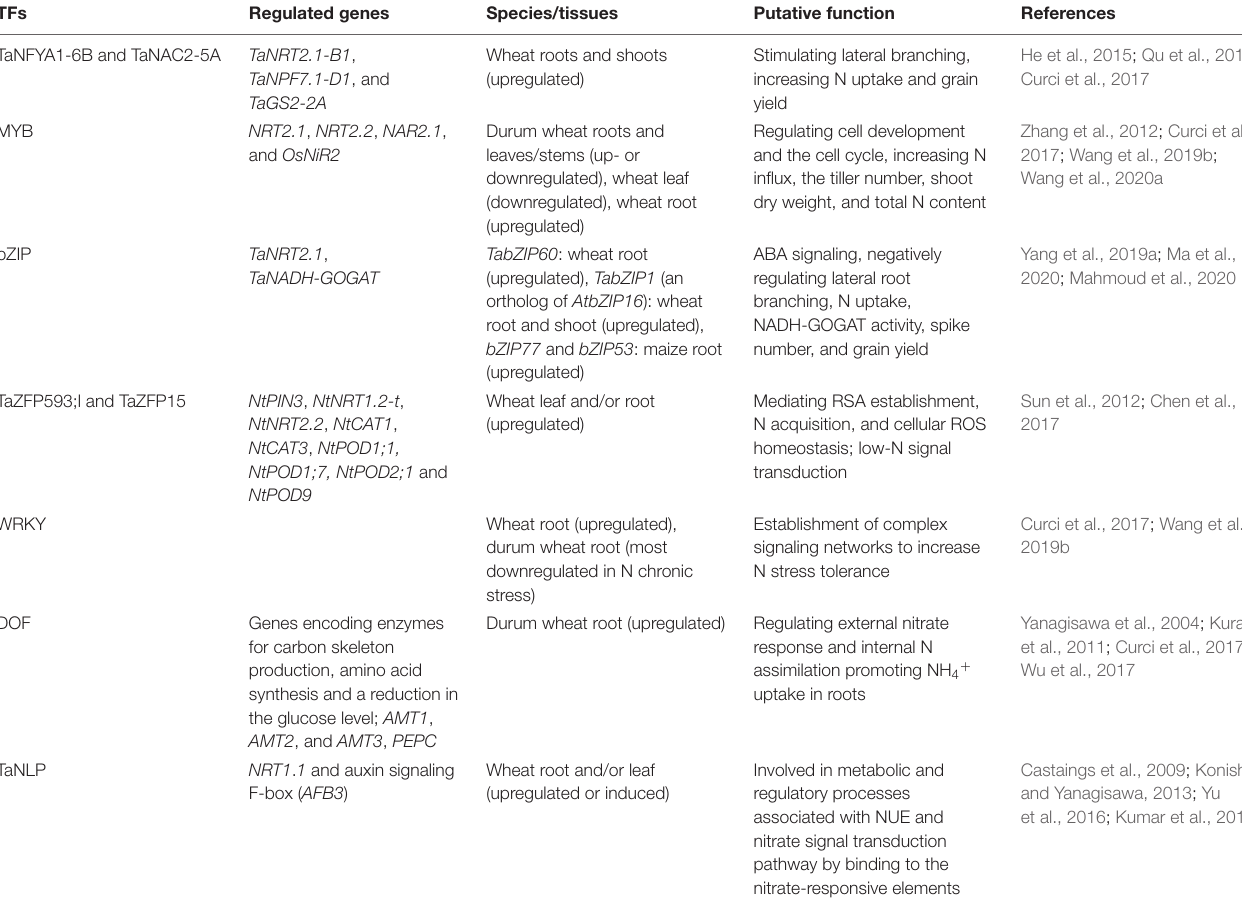
TABLE 1 | Transcript factors in response to N